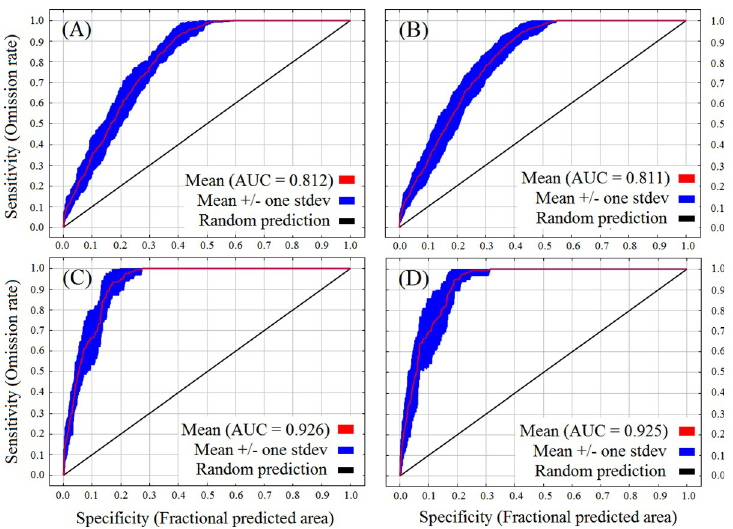
Fig 3. Receiver operating characteristic (ROC) curve for the predicted distribution MaxEnt models averaged over the ten replicate runs: Ageratina adenophora (the “current” year–A; year 2050 –B) and Lantana camara (the “current” year–C; year 2050 –D).